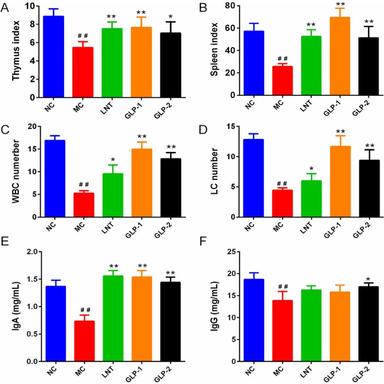
Effects of two G. lucidum polysaccharides on immunosuppressive mice. (A) Effects on thymus index. (B) Effects on spleen index. (C) The number of white blood cells. (D) The number of lymphocyte cells. (E) IgA levels in serum. (F) IgG levels in serum. Data were expressed as mean ± S.E.M. of nine mice. ##P b 0.01, compared with normal control group, \\P b 0.05 and P b 0.01 compared with model control group.